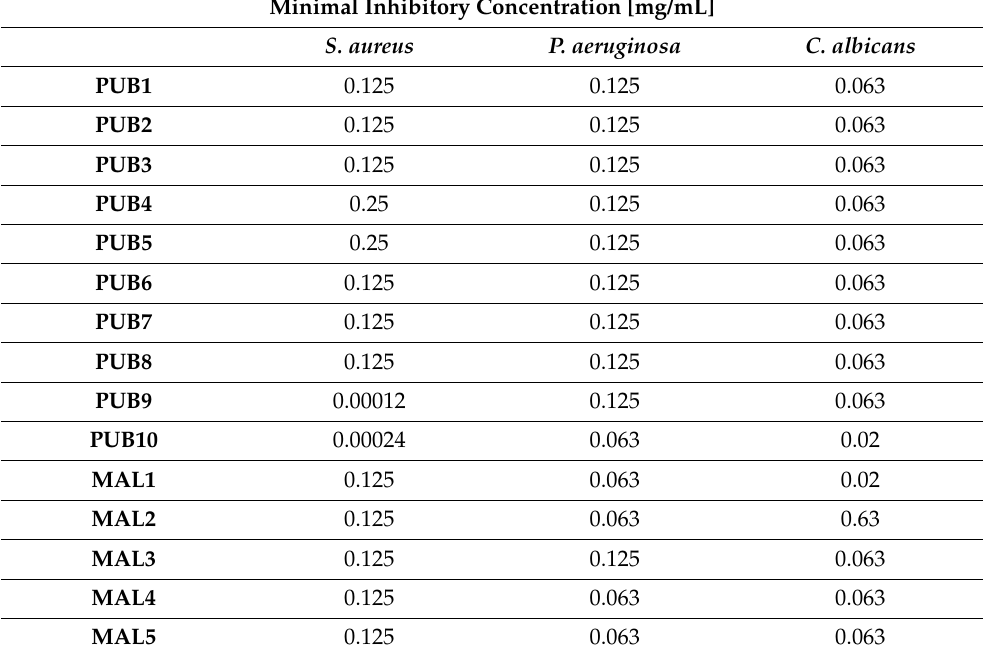
Table 1. The Minimal Inhibitory Concentration [mg/mL] of tested compounds towards S. aureus 6538, P. aeruginosa 15442 and C. albicans 103231 tested in microplate model. Minimal Inhibitory Concentration [mg/mL] S.